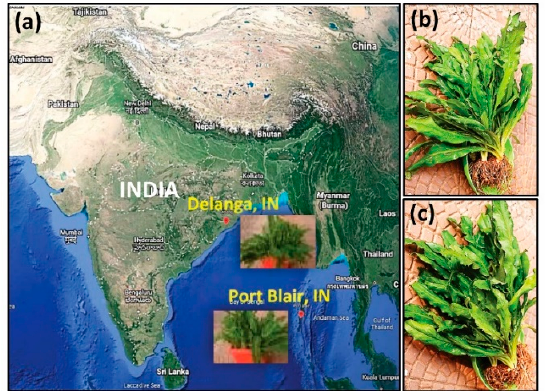
Figure 1. The geographical location ( a ) of the Eryngium genotypes collected from Delanga (20° 03 ′ N, 85° 76 ′ E, and 0 masl), Odisha, India ( b ), and Port Blair (11° 62 ′ N, 92° 72 ′ E, and 16 masl), Andaman and Nicobar Island, India ( c ) (source: http://earth.google.com/web, assessed on 4 September 2022).